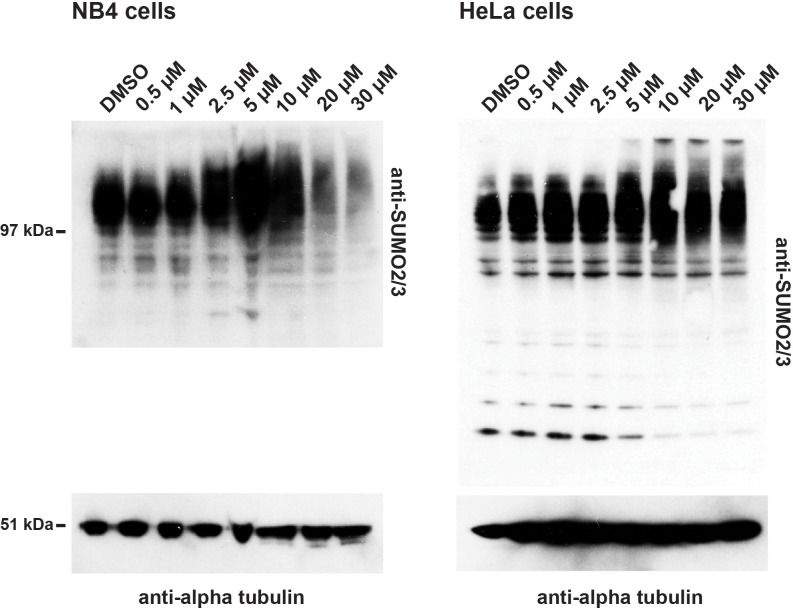
Hinokiflavone treatment leads to an increase in SUMO2/3 modified proteins in HeLa and NB4 cells.HeLa and NB4 cells were each treated with either DMSO (control), or with 0.5 µM, 1 µM, 2.5 µM, 5 µM, 10 µM, 20 µM, or 30 µM hinokiflavone for 24 hr. SUMO2/3 and alpha tubulin were detected by western blotting.